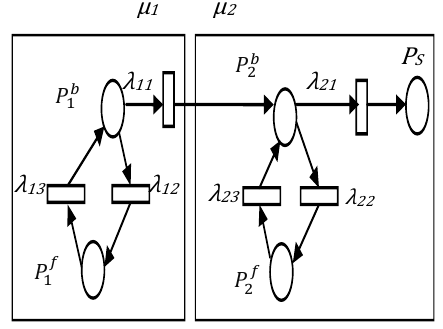
Figure 2. Sequence components model based on SPN.